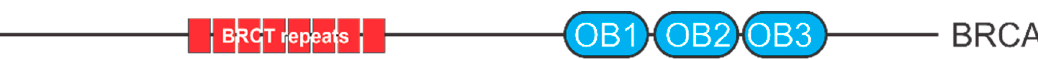
Figure 6. BRCA2 structural motifs. OB-folds are depicted as ovals with other motifs depicted as rectangles. BRC repeats and N- and C-terminal motifs are as